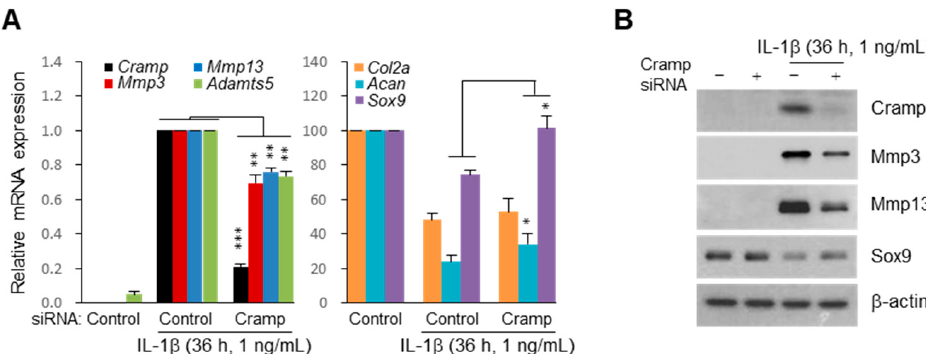
Figure 4. Small interfering RNA (siRNA) knockdown (KD) of Cramp attenuates catabolic factor expression induced by IL-1 β . Chondrocytes transfected with control or Cramp siRNA were treated with IL-1 β for 36 h. ( A ) mRNA levels of catabolic factors (left) and anabolic factors (right) were determined by qPCR ( n = 4). Values are the means ± SEM. * p < 0.05, ** p < 0.01, *** p < 0.001. ( B ) Cellular Cramp, Sox9, and β -actin and extracellular Mmp3 and Mmp13 were determined by Western blotting. Data from one representative experiment of two independent experiments are shown.